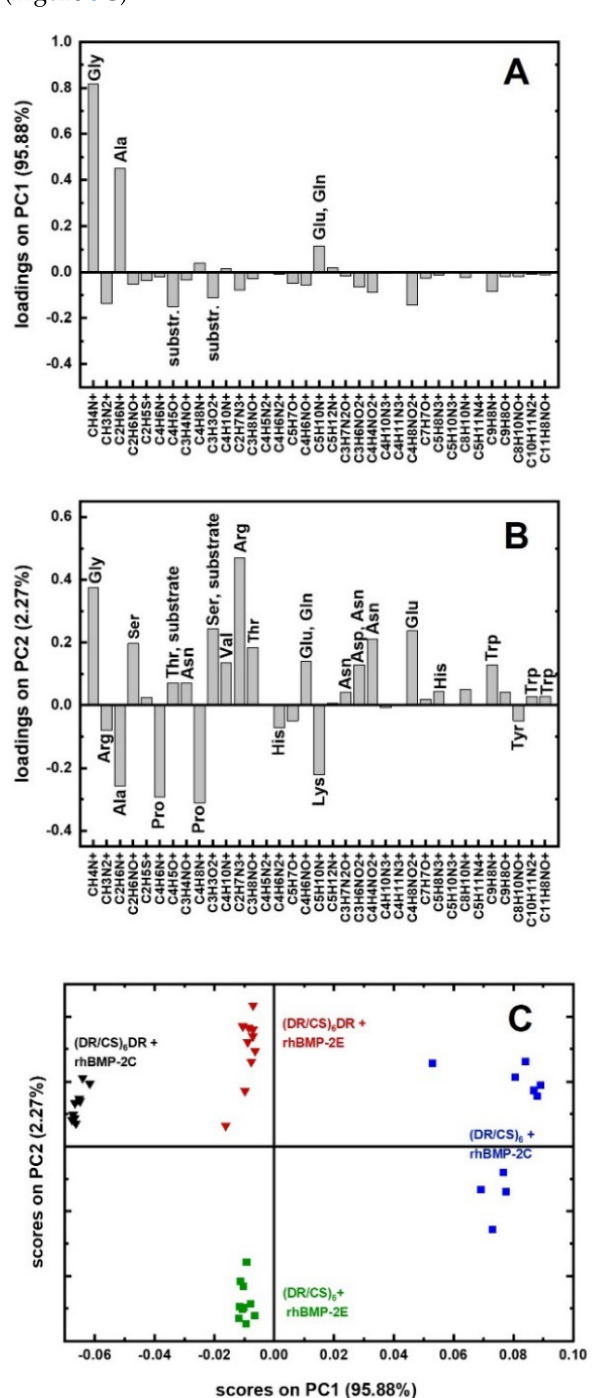
Figure 5. TOF-SIMS analysis of the rhBMP-2 dimer covalently and electrostatically bonded to (DR/CS) 6 and (DR/CS) 6 DR. ( A ) PC1 is loaded negatively and positively by the mass signals of amino acids and substrates, respectively. ( B ) PC2 is loaded negatively and positively by the mass signals of amino acids exposed to the surface; PC2 is loaded positively by the mass signals of Arg, Ser, and Gly and negatively by the mass signals of Ala, Pro, and Lys, which relates to the different structural state of rhBMP-2. ( C ) Scores plot with four groups of data points, centered in different quadrants of the coordinate system PC1 vs. PC2, corresponding to all